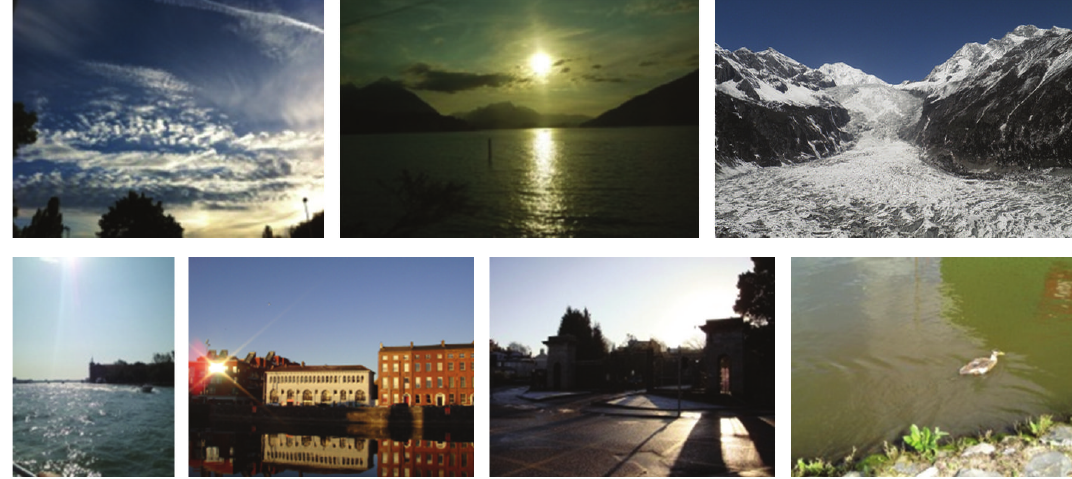
Figure 1: A subset of test images, from top-left to right-down: sky, sun, snow, sea, building, gate, and river.